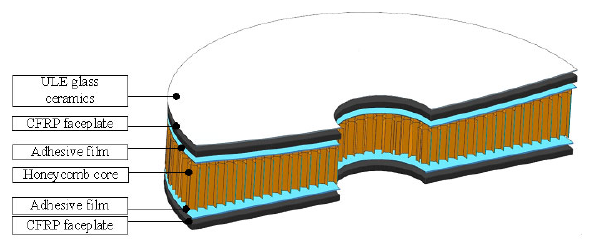
Fig. 1 Component of the CFRP